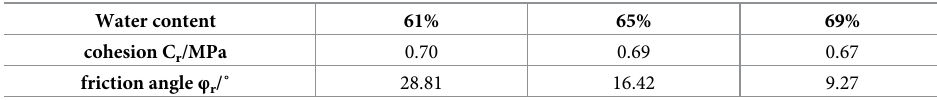
Table 4. Relations between residual cohesion, residual friction angle and water content.